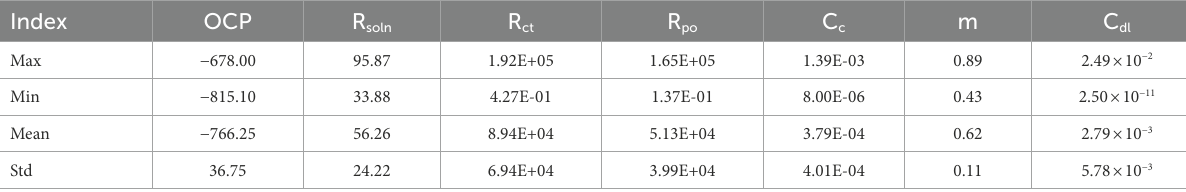
TABLE 3 Characteristics of the GAN based synthetic corrosion data used in machine learning